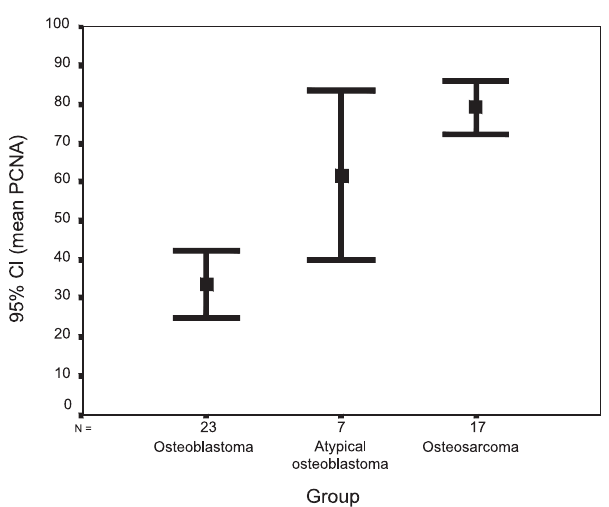
Figure 9 - Mean values of PCNA labeling indexes in classical osteoblastoma, (33.7%) atypical osteoblastoma (61.7%), and osteosarcoma. (79.3%)